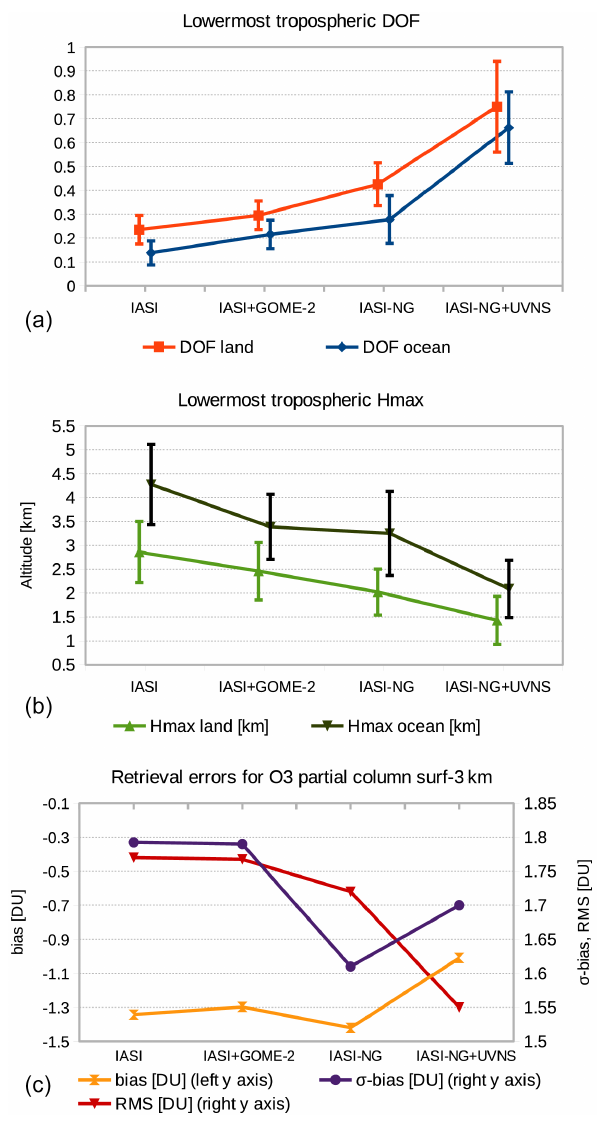
Figure 6. Average values of DOF-3km (a) ; Hmax-3km [km] (b) ; bias [DU], σ -bias [DU] and rms [DU] (c) of the O3-3km PO– PR distribution from IASI, IASI + GOME-2, IASI-NG and IASI- NG + UVNS, for 8–11 July 2010 over